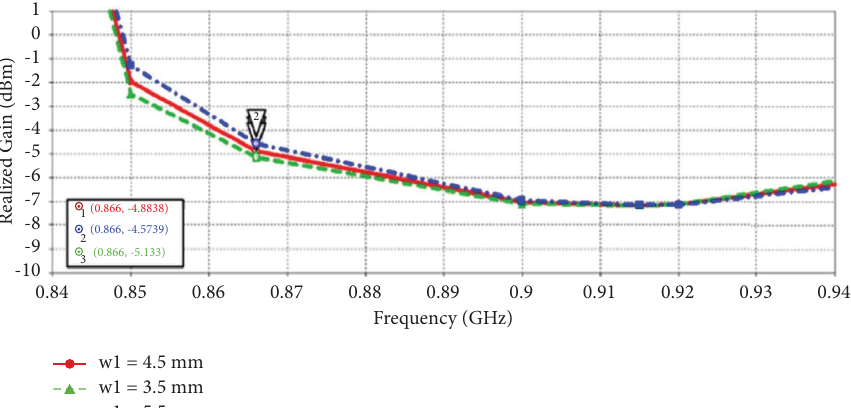
Figure 8: Gain performance of the tag with varying “ w